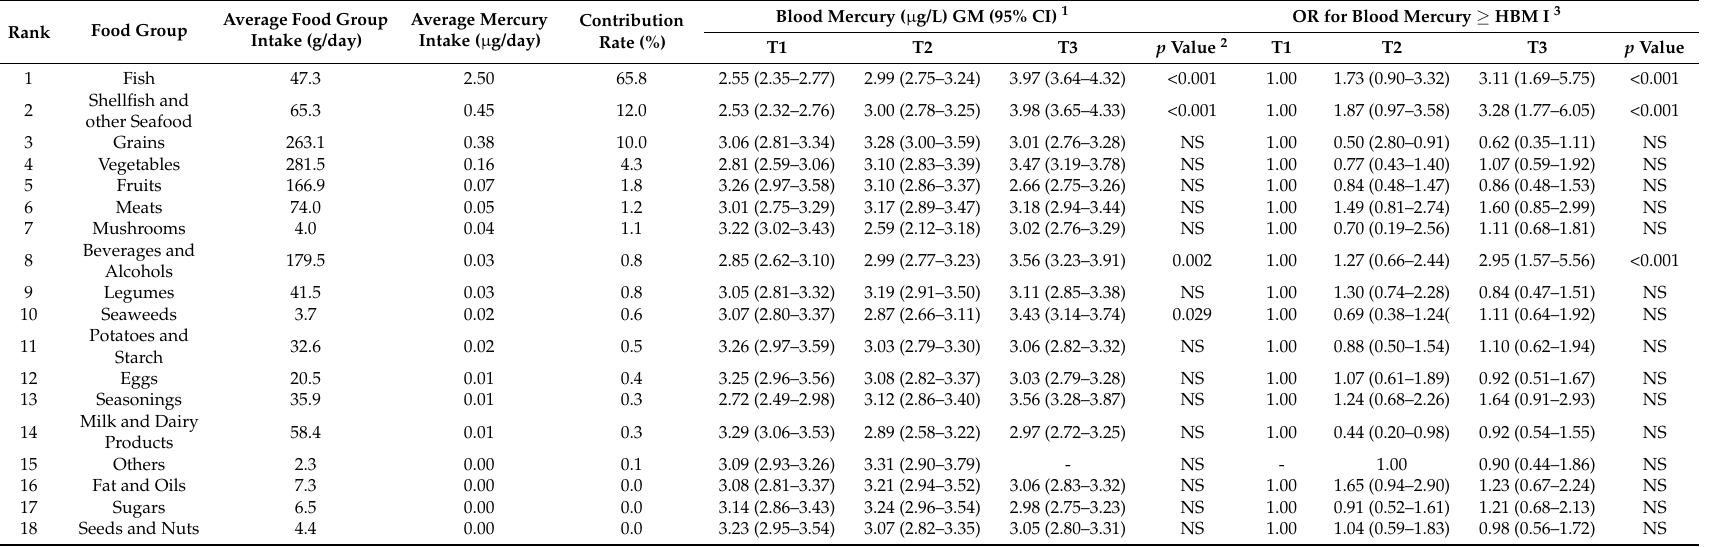
Table 5. Contribution rate to mercury intake, the blood mercury concentration and Odds Ratios for blood mercury ≥ the HBM I value according to the food group